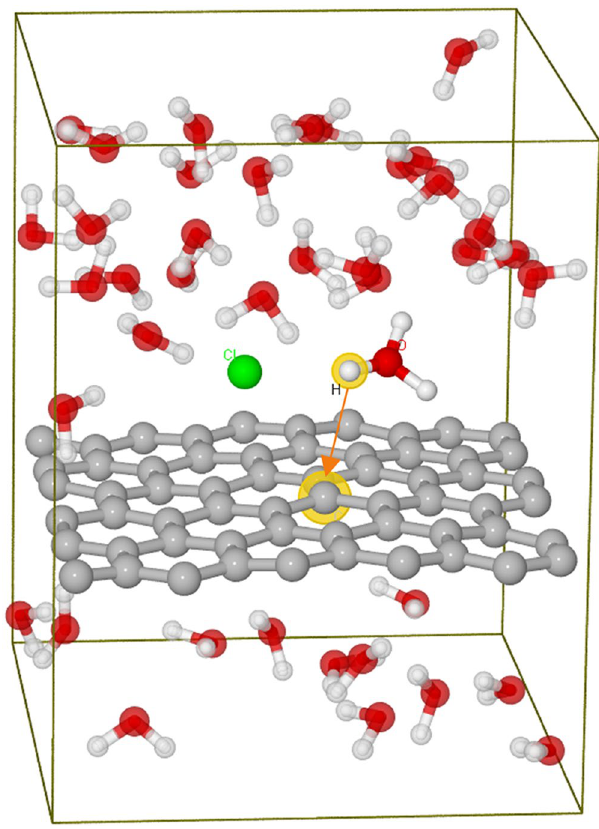
Figure 1. A simulation box of a graphene membrane for calculating PTBs, consisting a single layer graphene in a water solution of hydrochloric acid. The HCl molecule dissociates into a hydronium ion and a chloride ion. The proton is labelled with a yellow halo, which is approaching the C atom with a halo, as pointed by the arrow. The white, red, grey and green spheres are hydrogen, oxygen, carbon and chlorine atoms,